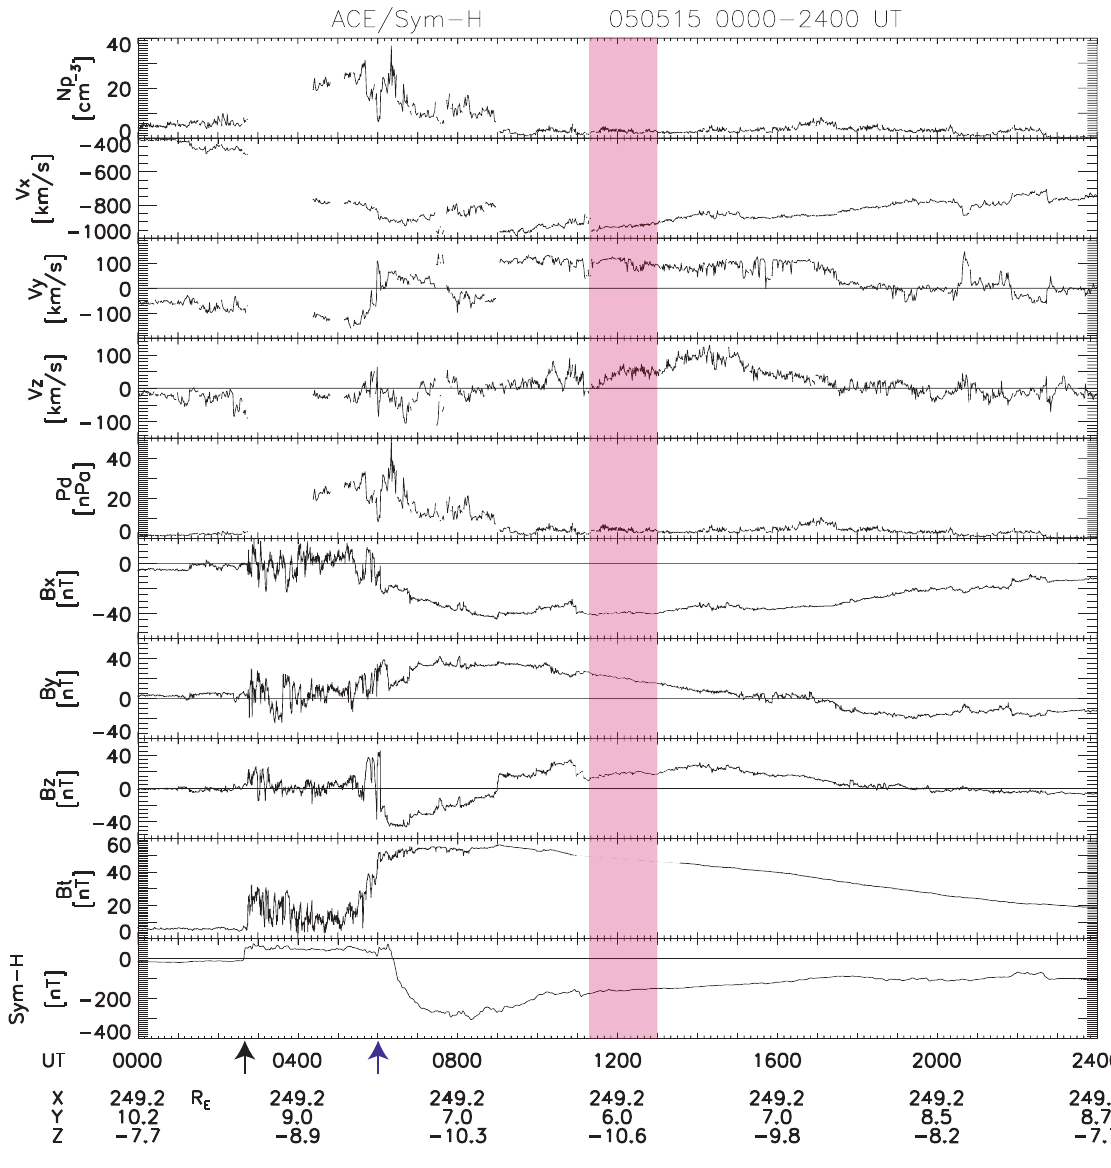
Fig. 1. Solar wind data (in GSM) obtained by ACE (shifted 34 min forward). The Sym- H index is also displayed at the bottom. The hatched period is examined by using Geotail data. The arrivals of the interplanetary shock front and the main body of the CME are seen at 02:40 UT (black arrow) and 06:00 UT (purple arrow), respectively.